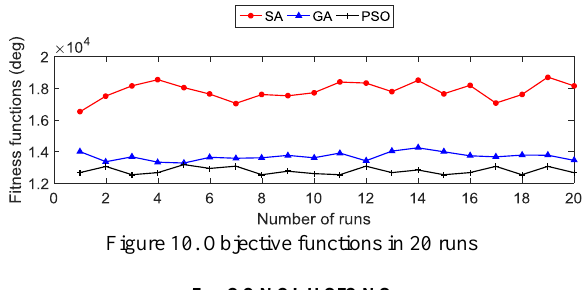
Figure 10. Objective functions in 20